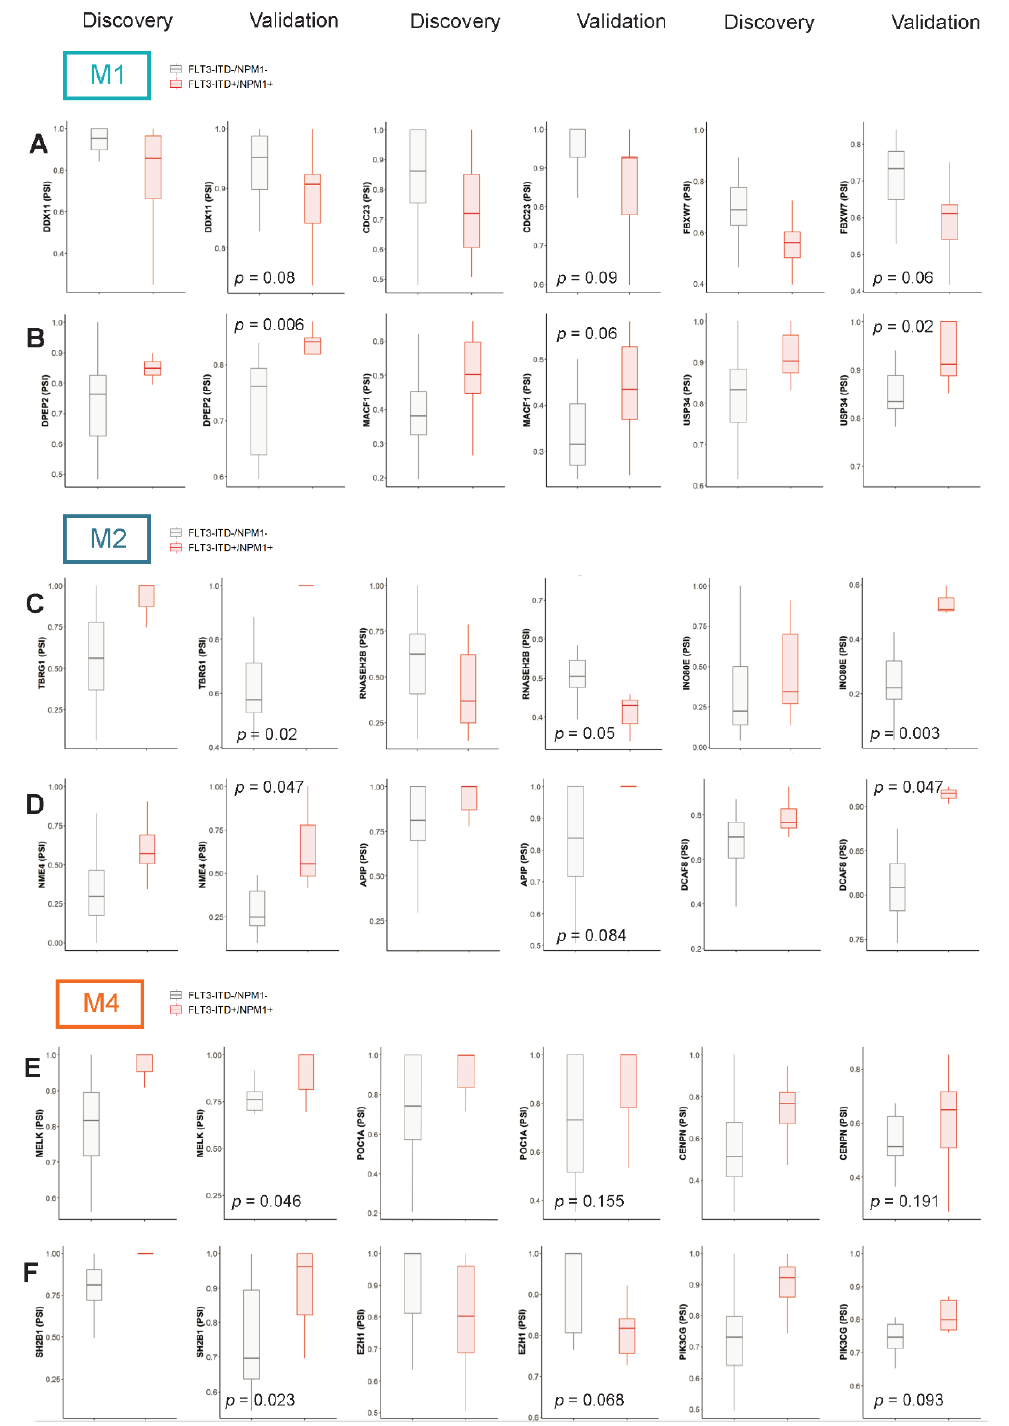
Figure 5. Validation of selected differential splicing events in an independent sample set. The figure depicts PSI values for selected differential splicing events in our initial discovery cohort (all events with FDR < 0.05 and |ΔPSI| > 0.1) and an independent validation cohort in M1, M2 and M4 FAB types. ( A , C , E )—Selected splicing events affecting genes involved in cell cycle regulation and DNA damage response in M1 ( DDX11, CDC23, FBXW7 ), M2 ( TBRG1, RNASEH2B, INO80E ) and M4 ( MELK, POC1A, CENPN ) FAB types, respectively. ( B , D , F ) Selected splicing events affecting genes involved in signaling pathways in M1 ( DPEP2, MACF1, USP34 ), M2 ( NME4, APIP, PCAF8 ) and M4 ( SH2B1, EZH1, PIK3CG ) FAB types, respectively.